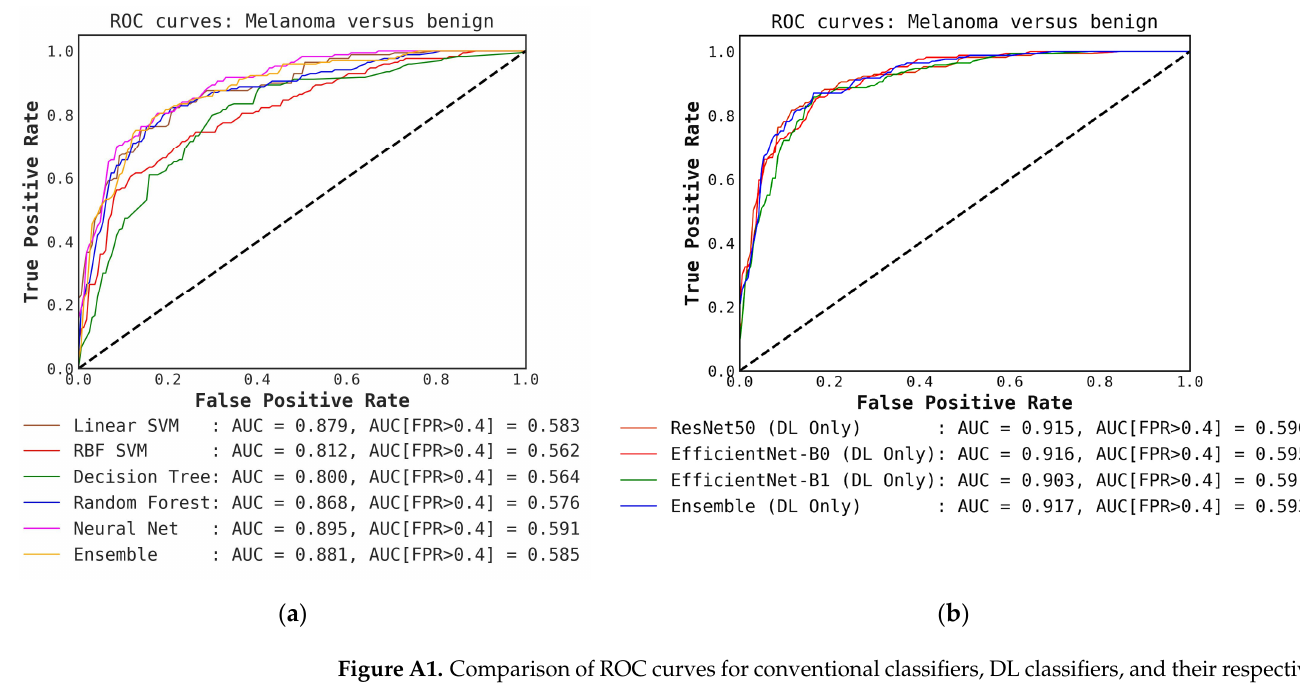
Figure A1. Comparison of ROC curves for conventional classifiers, DL classifiers, and their respective ensembles obtained by averaging the output probabilities. ( a ) ROC curves for conventional classifiers applied directly to hand-crafted features, without cascade generalization; ( b ) ROC curves for the deep learning (DL) models only and their ensemble. The area under the curve (AUC) and the AUC for a false-positive rate higher than 0.4 are both presented for comparison. All values are rounded to three significant digits.